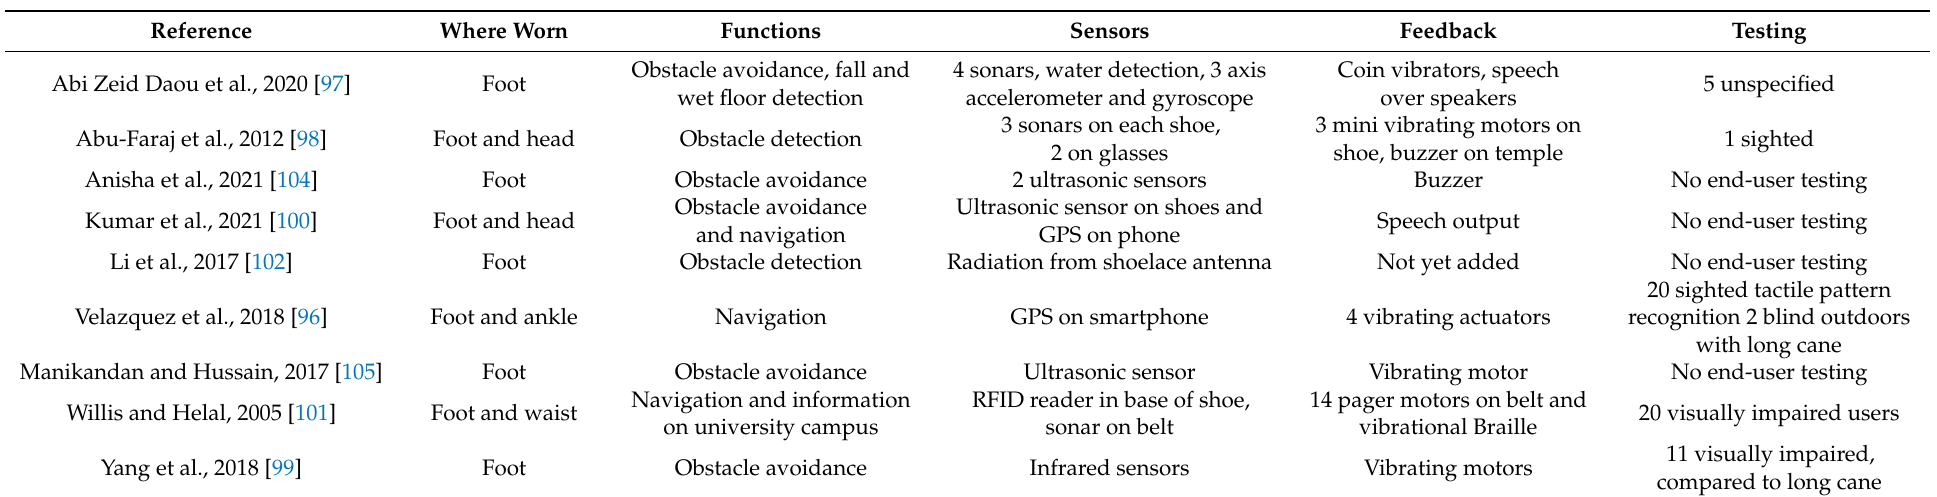
Table 5. Device features and testing for foot-worn